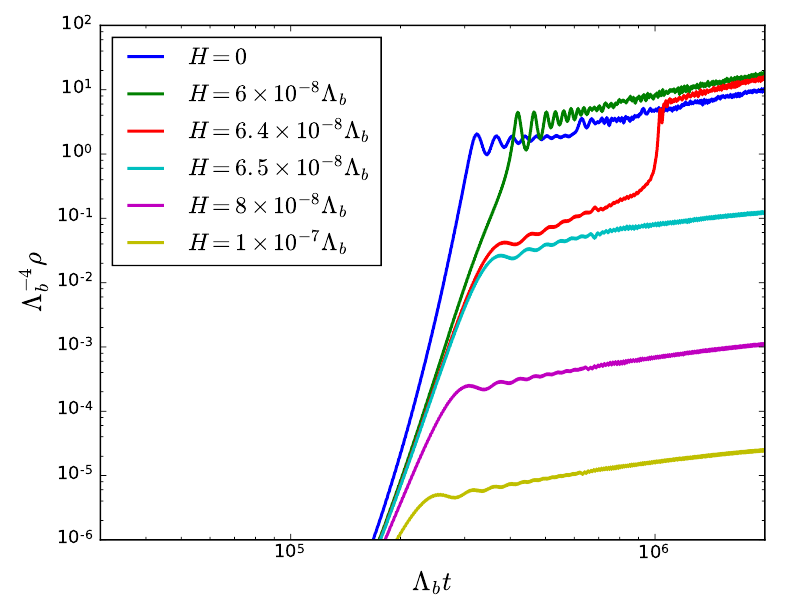
Figure 13 . Time evolution of the energy of the (cid:13)uctuations with f = 1000(cid:3) b , _ (cid:30) 0 = 10(cid:3) 2 (cid:22) 3 = 3 H _ (cid:30) 0 . For small H , the evolution is fairly insensitive to it, while for larger values Hubble friction progressively reduces the e(cid:14)ciency of fragmentation. A transition is clearly visible around H ’ 6 : 4 (cid:2) 10 (cid:0) 8 (cid:3) b